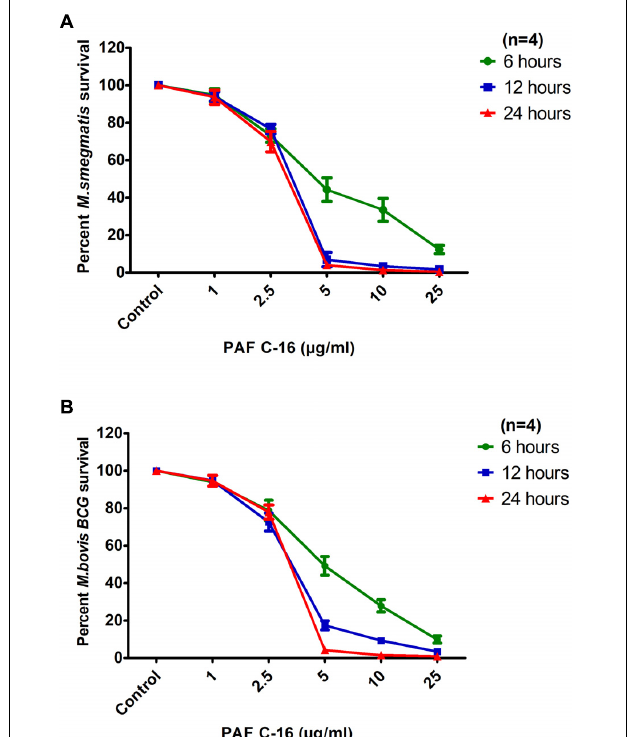
FIGURE 2 | Inhibitory effects of PAF C-16 on M. smegmatis and M. bovis BCG growth at increased incubation durations. Number of surviving colony forming units of M. smegmatis (A) and M. bovis BCG (B) after 6, 12, and 24 h of treatment with indicated concentrations of PAF C-16. Data is expressed in terms of percent survival where solvent control is taken as 100% survival. Each data point represents the average of four individual experiments performed in triplicate and the error bars show the standard error of mean values ( ±